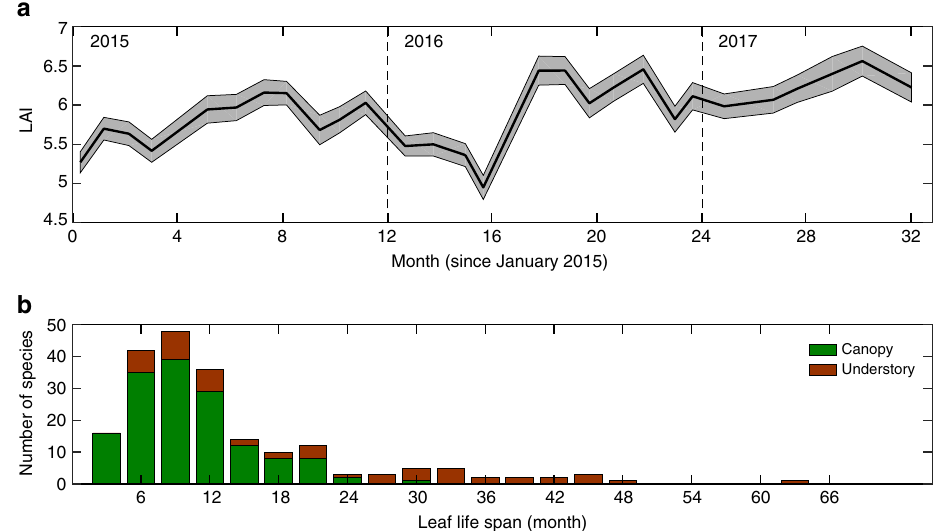
Fig. 7 Leaf area index (LAI) was lower during the El Niño 2015 – 2016 compared to the following period. a LAI estimated from hemispherical photographs taken at approximately monthly intervals in 188 locations on Barro Colorado Island. Shaded area includes ± standard errors around the mean. b Median leaf life span has a strong mode between 6 and 12 months and is almost always <24 months for canopy species. Median leaf life span is much longer in the understory for both understory shrubs and treelets and saplings of canopy trees. Data were collected in two nearby forests and include 77 species